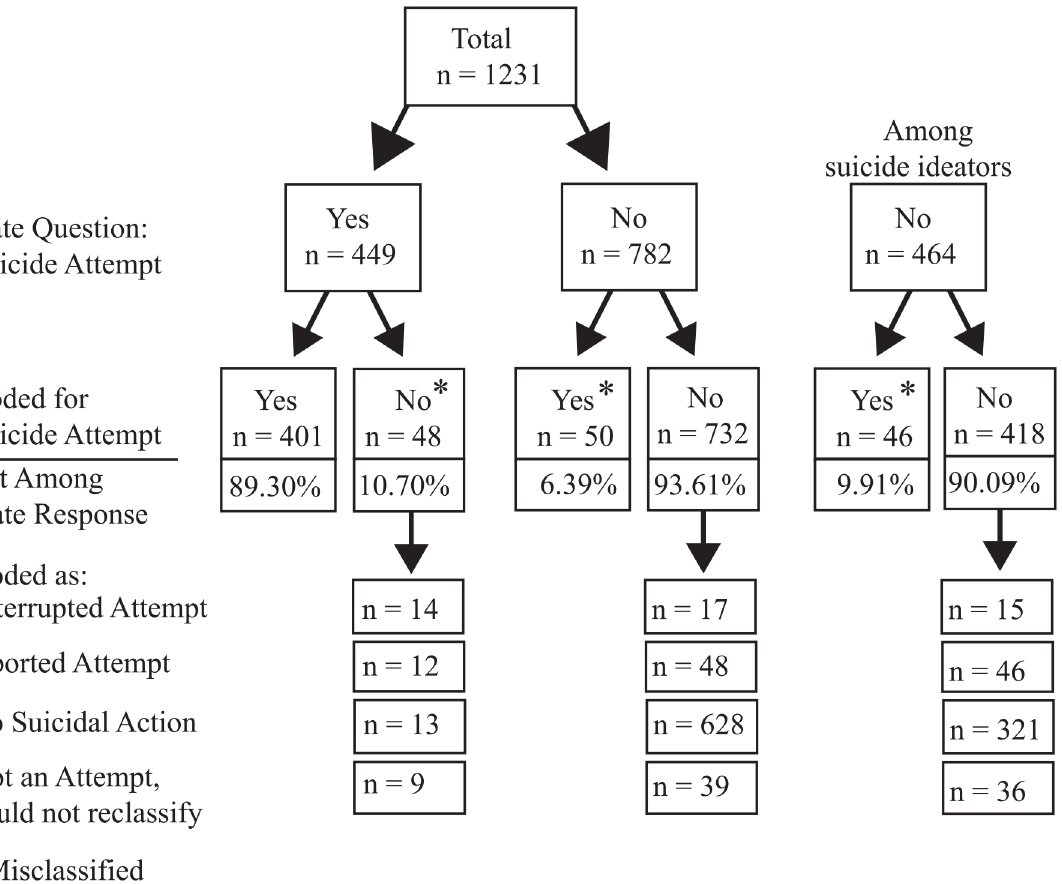
Fig 4. Responses to single-item suicide attempt question and the results of coded narrative responses. Single-item suicide attempt questions result in a 10.7% false positive rate and 6.39% false negate rate for the sample (9.91% false negative rate among ideators).